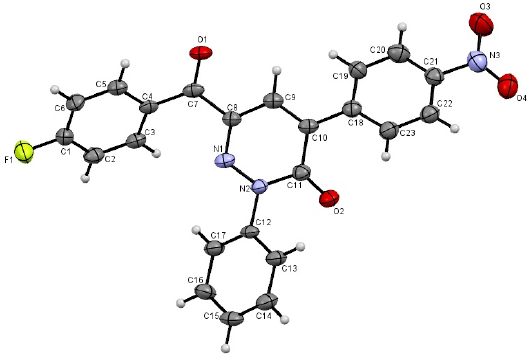
Figure 2. ORTEP plot of the X-ray crystallographic data determined for 3d [38].